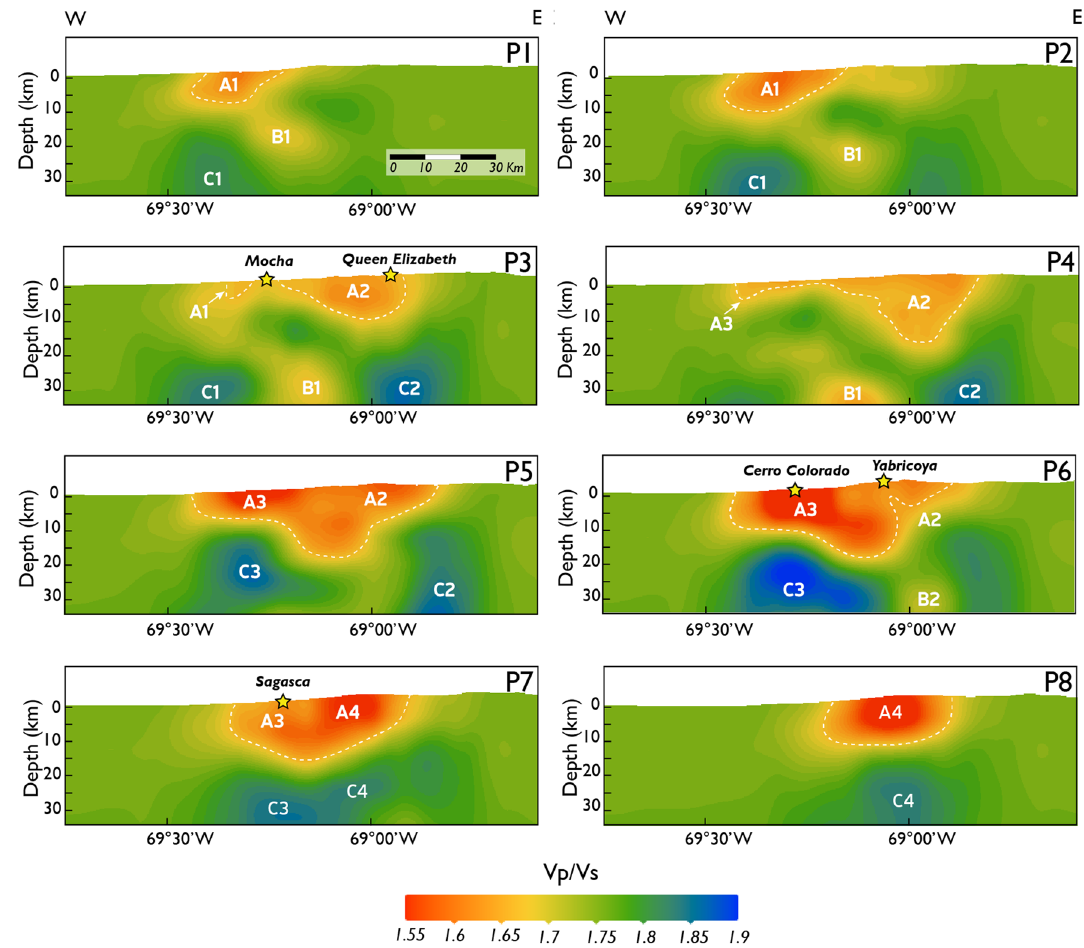
Figure 5. Vertical sections for Vp/Vs ratios along profiles P1-P8 (see Fig. 4 for map location). The white dotted curves denote low Vp/Vs areas. The yellow stars (surface) correspond to historical porphyry copper deposits and prospects included in the study area. A (A1 to A4), B (B1 and B2) and C (C1 to C4) anomalies correspond to the low, medium, and high Vp/Vs anomalies, respectively, described in the text. Data georeferencing was carried out with ArcGIS Pro10.1 (www. esri. com). The software used to generate this figure was Leapfrog 2022.1 (www. seequ ent. com) and the final editing was done with Adobe Illustrator 2022 (www. adobe.